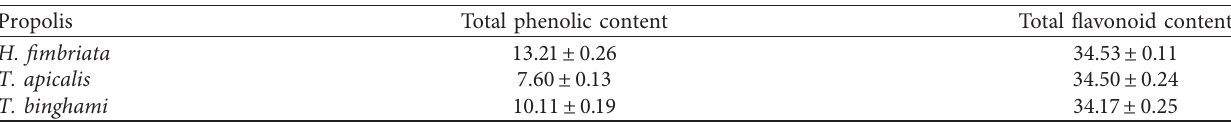
Table 2: Total phenolic content (TPC) and total flavonoid content (TFC) of H. fimbriata , T. apicalis , and T. binghami propolis water extracts